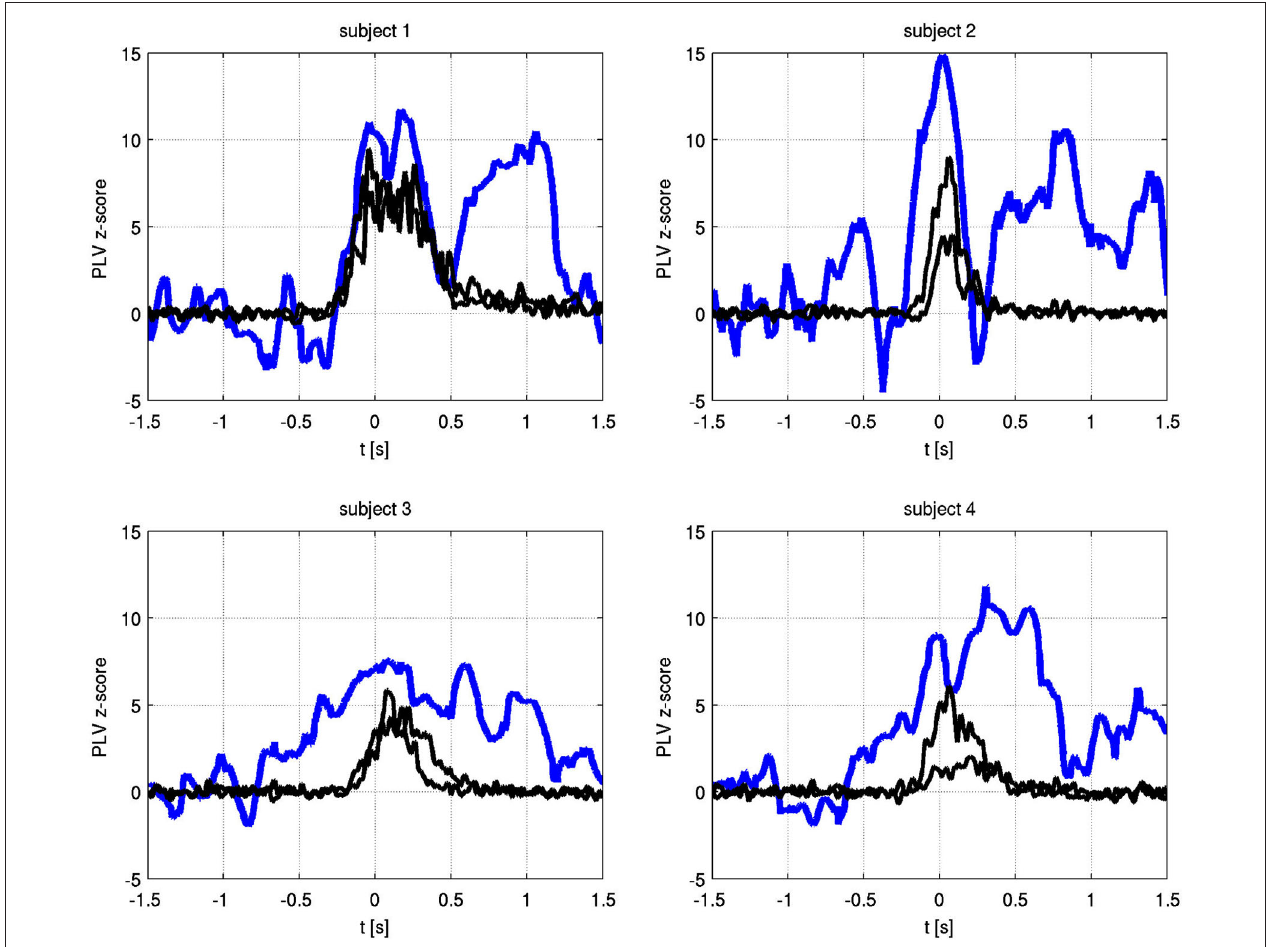
the baseline period. Only the significant channel pair for each subject is shown (subject 1: C1 right to C1 left, subject 2: C3 right to C1 left, subject 3: C1 right to C2 left, subject 4: C2 right to C2